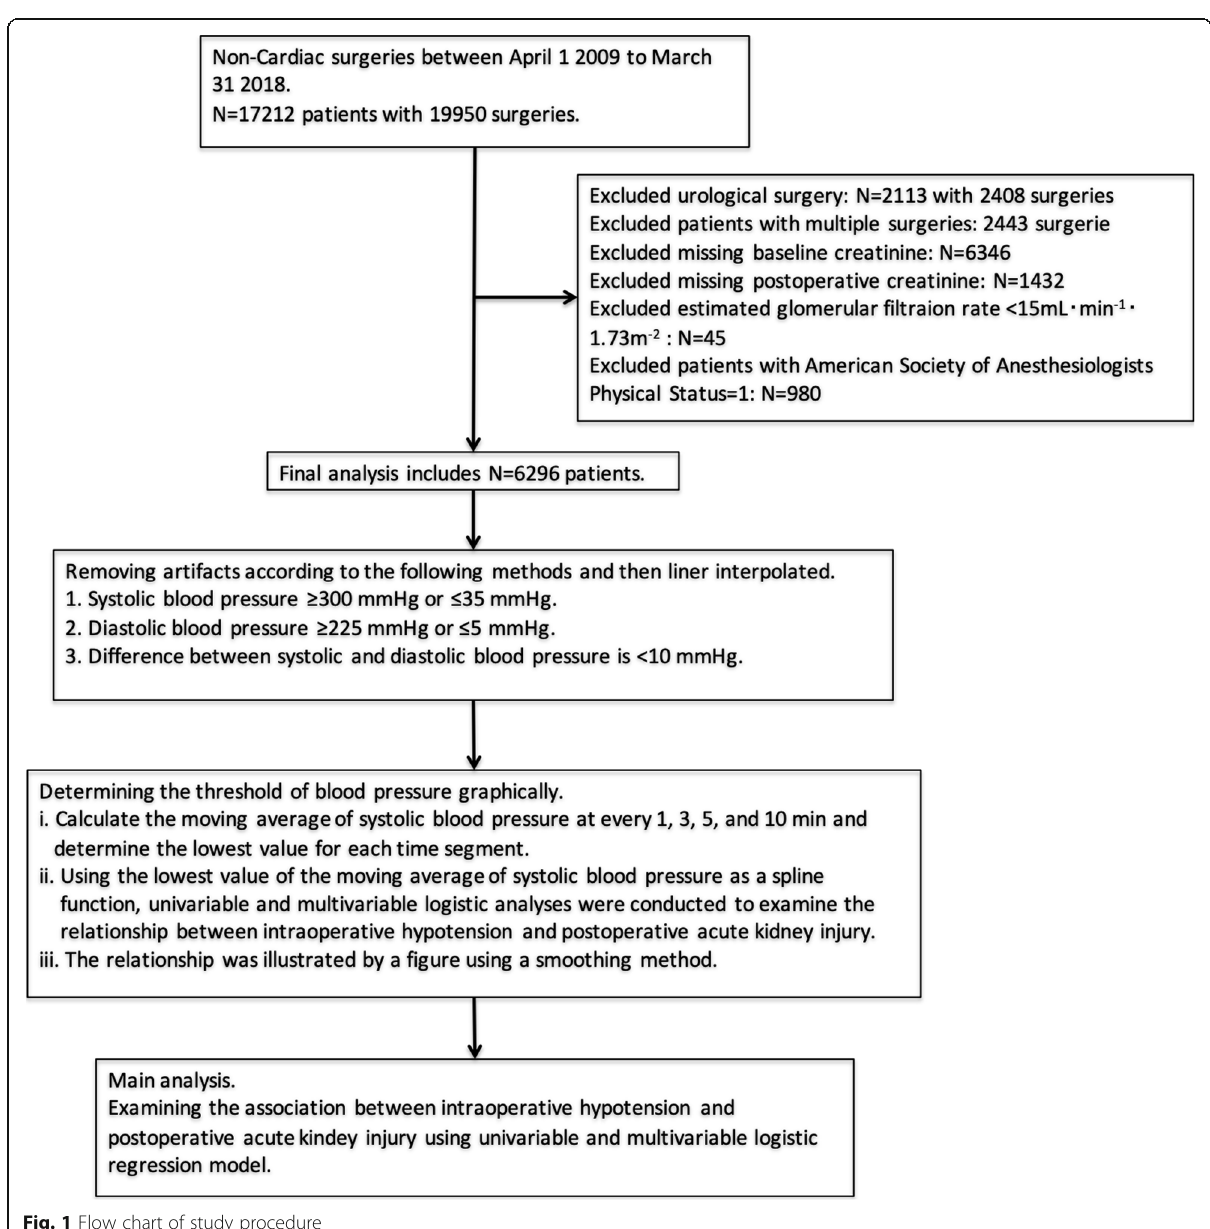
Fig. 1 Flow chart of study